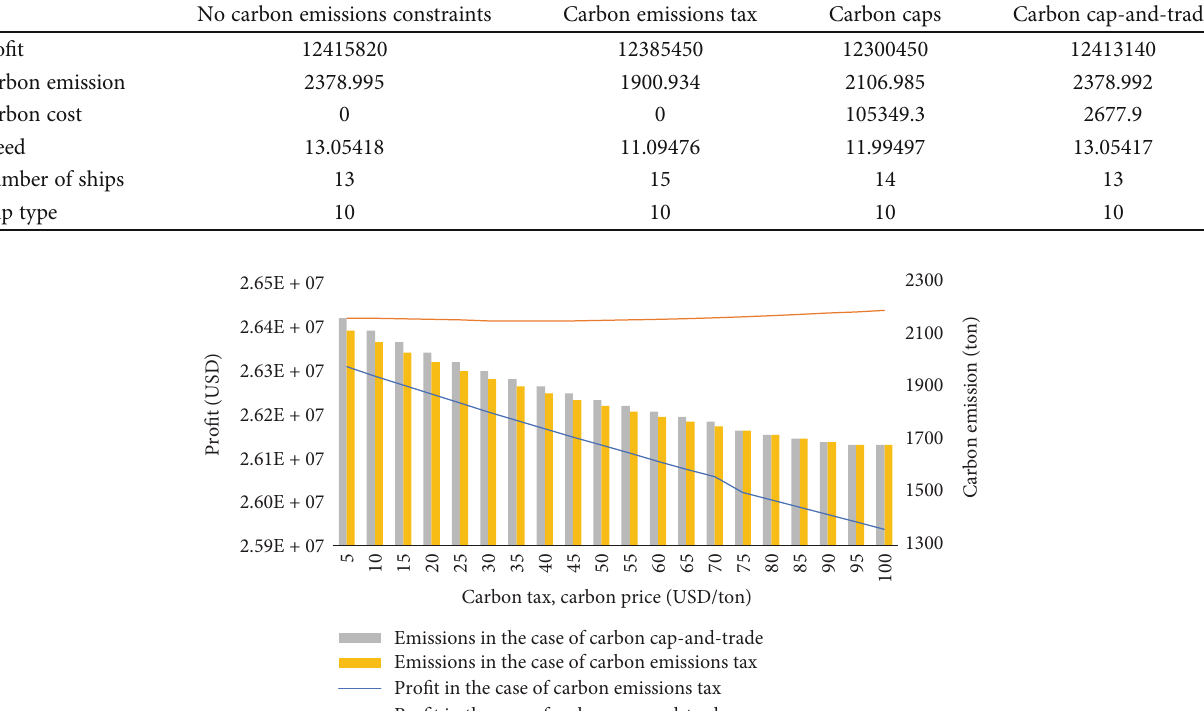
Table 8: Computation results for di ff erent forms of carbon